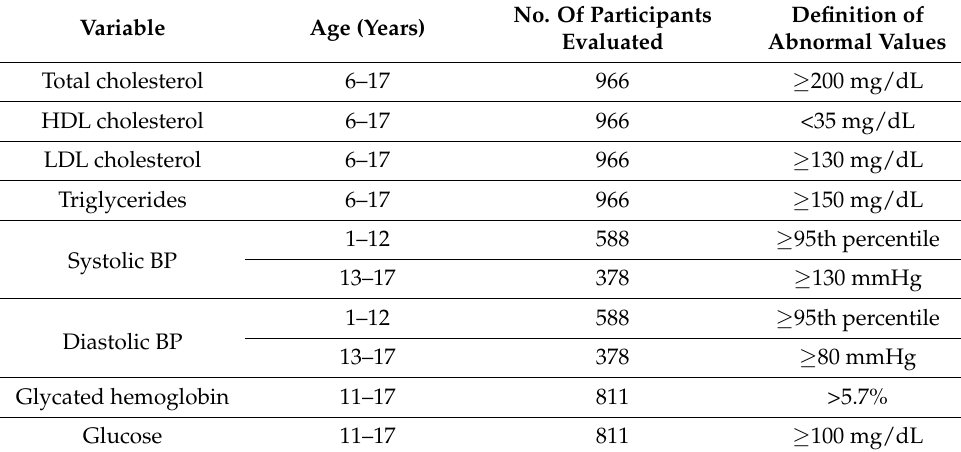
Table 1. Definition of cardiometabolic risk factor